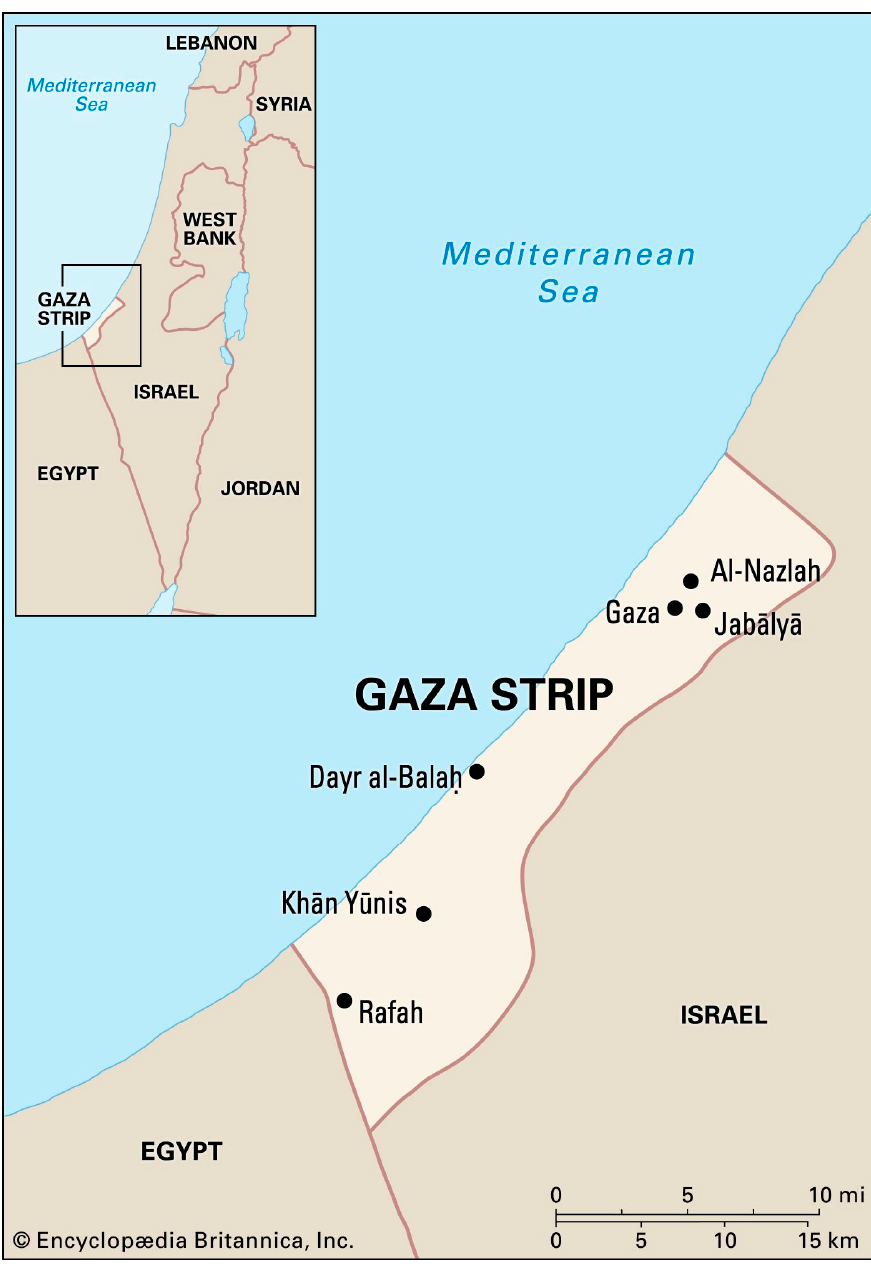
Figure 1. Map of the Gaza Strip.